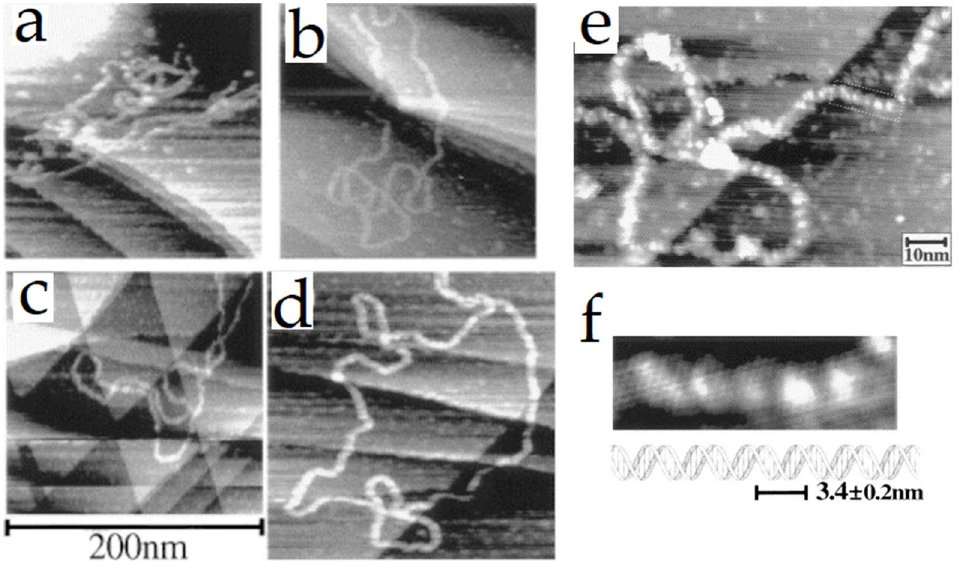
Figure 2. STM images of 2739 base-paired double-stranded plasmid DNA molecules deposited on a Cu (111) surface. The samples were deposited using the pulse injection method. Typical STM images of plasmids ( a – d ). A magnified image of a fragment of ( d ) is shown in ( e ) and a high-resolution image of a selected area of ( e ) shows a periodic structure with a periodicity of 2.6–3.6 nm along the strand is visible ( f ). For comparison, one scheme of DNA at the same scale is included. Reprinted with permission from Ref. [42] . Copyright (1999), Elsevier.